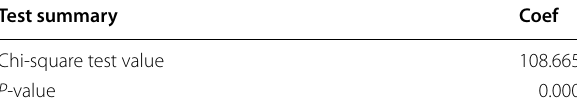
t statistics in parentheses, ** p < 0.10, *** p < 0.05 Table 9 Hausman (1978) specification